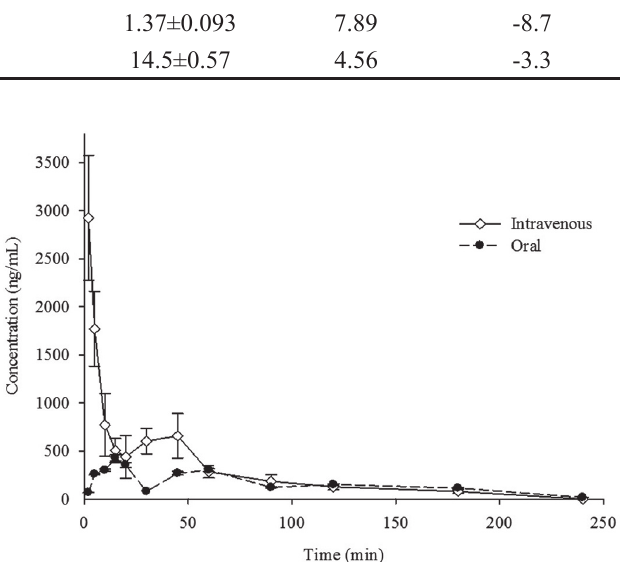
FIGURE 3 - Mean plasma concentration–time curves of oleracimine in rats (mean ± S.D., n = 5) after the intravenous and oral administrations at a dose of 2.5 mg · kg -1 . These sampling points, which could not be detected, that is, plasma concentrations under the LOQ, were not included in the mean plasma concentration–time